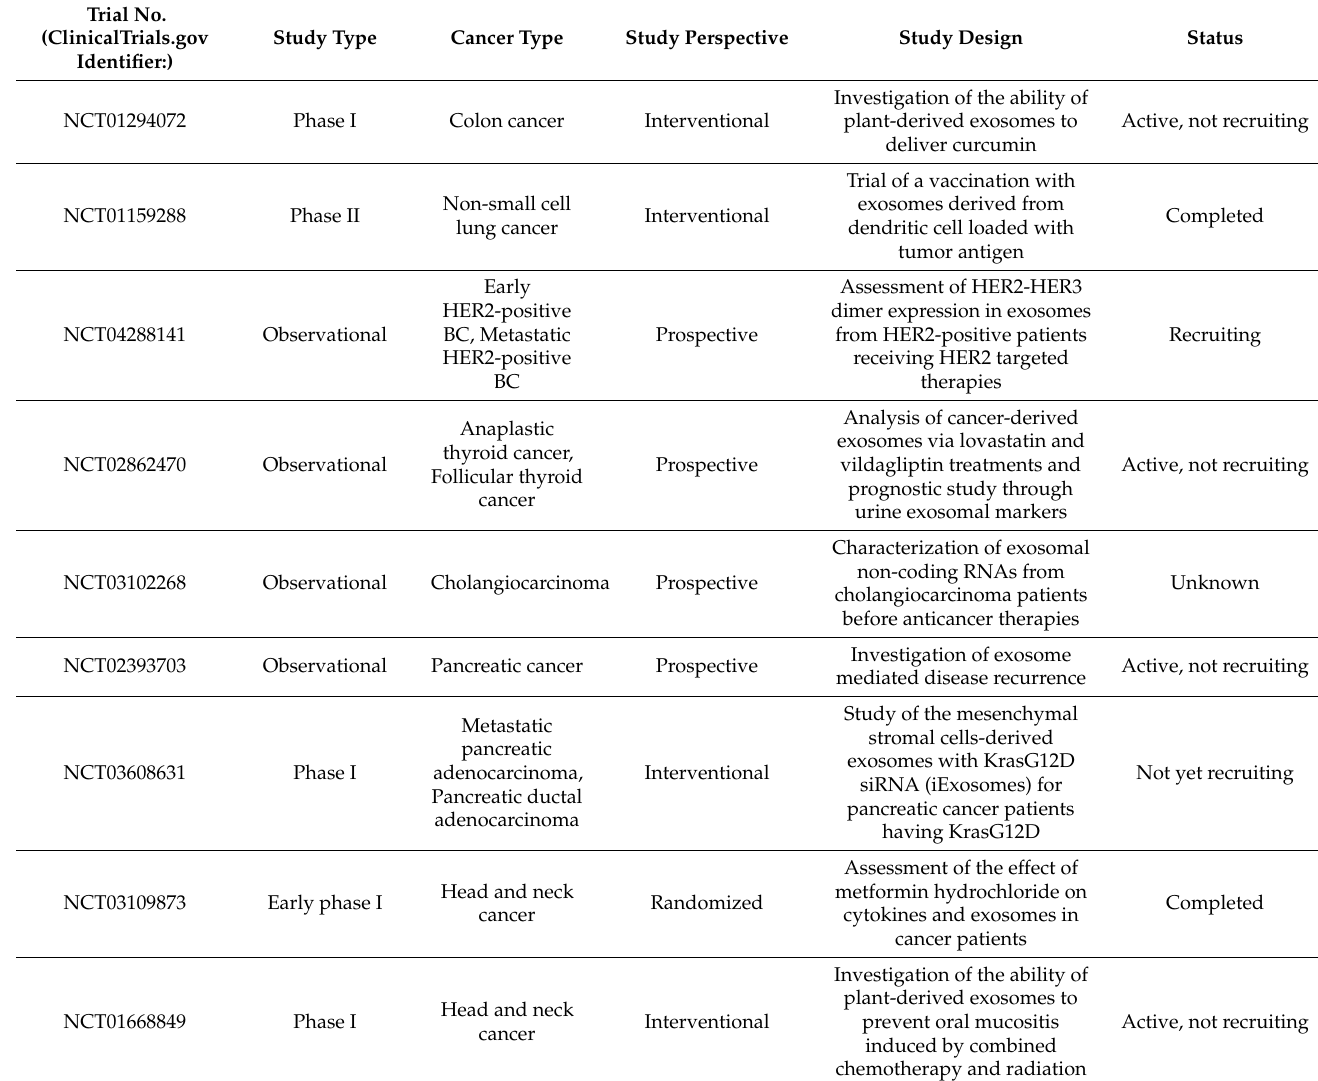
Table 5. Clinical trials on